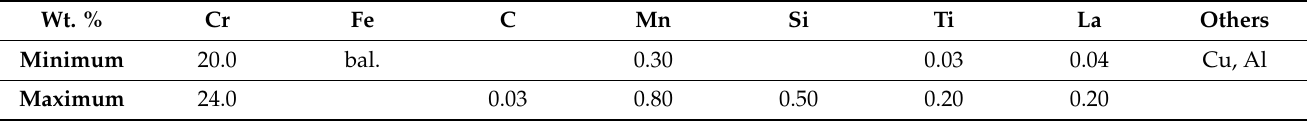
Table 2. Crofer22APU chemical composition (wt. %) according to the ThyssenKrupp datasheet